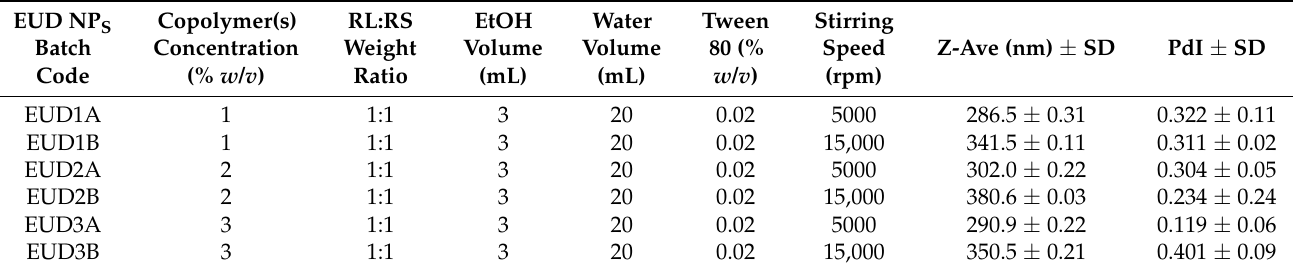
Table 1. Production conditions and features of blank Eudragit